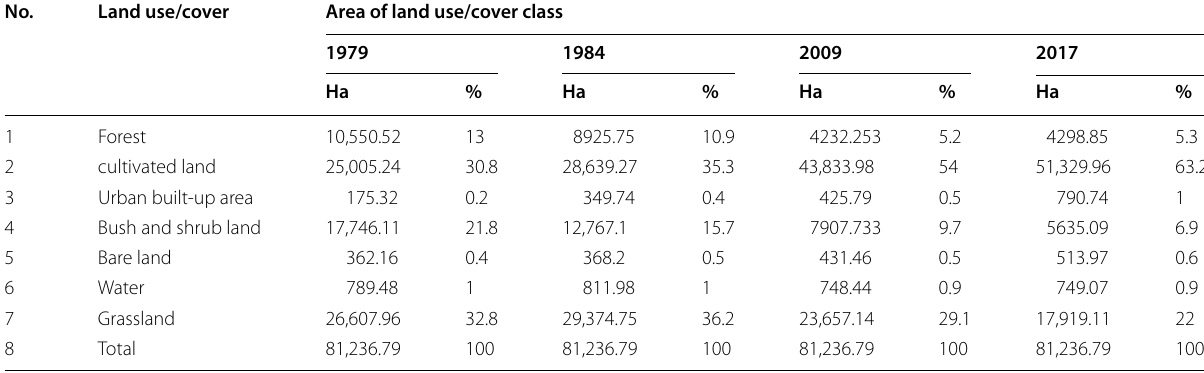
Table 3 Proportion of land use/land cover change in Huluka/Ambo Town’s Watershed (1979–2017) No.